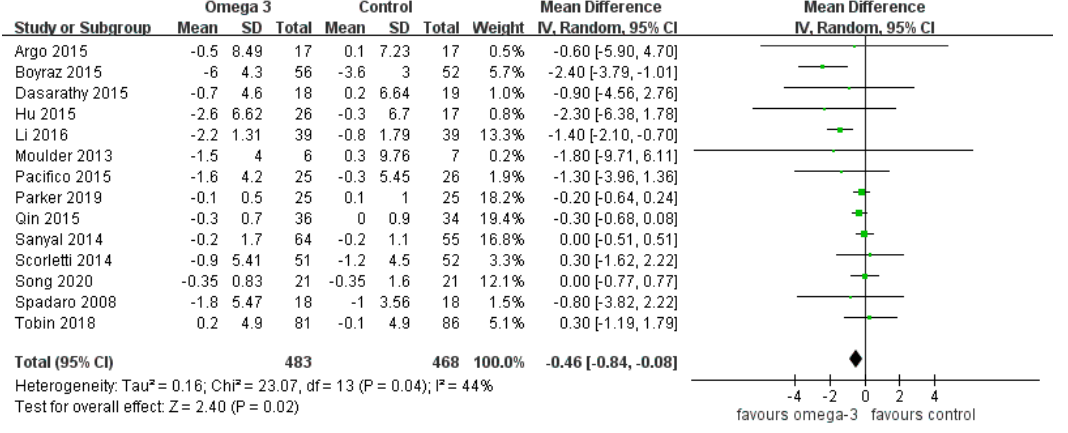
Figure 7. Effect of omega-3 fatty acid on body mass index. Figure 7. E ff ect of omega-3 fatty acid on body mass